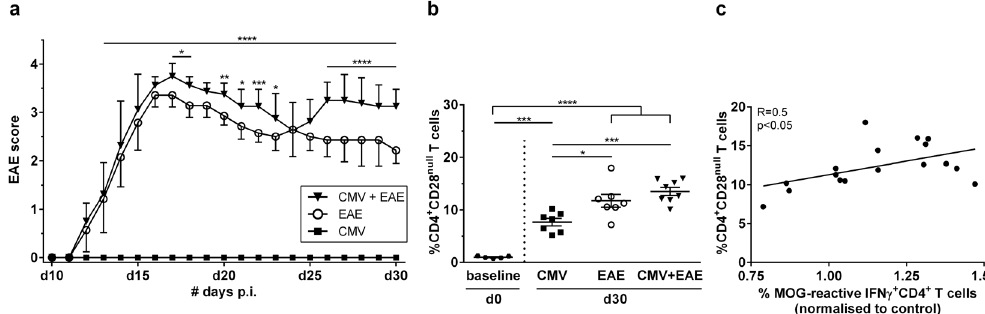
Figure 3. MCMV infected mice with EAE have a worse disease course. Mice were infected with MCMV and after 8 days EAE was induced. ( a ) Daily scoring of the CMV, EAE and MCMV infected EAE groups (n = 8/ group). ( b ) Splenocytes were isolated at day 0 (baseline) and day 30 and CD4 + CD28 null T cells were measured via flow cytometry. ( c ) After stimulation of splenocytes with a MOG 35–55 peptide, the IFN γ producing CD4 + T cells were measured via flow cytometry and normalized to the non-peptide control. The MOG response significantly correlated with the percentage of CD4 + CD28 null T cells in the spleen. * p < 0.05, ** p < 0.01, *** p < 0.001, **** p <